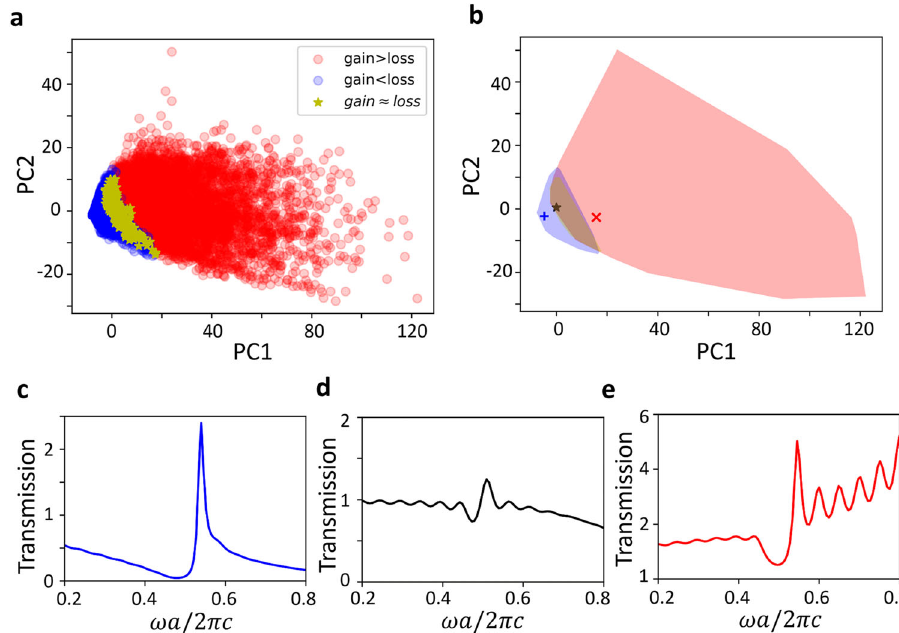
Fig. 3 Principal component analysis for the transmission spectra generated from a fi ve-layer periodic non-Hermitian structure. a Representation of the fi rst two principal components (PC1 and PC2) of the transmission spectra. b The corresponding convex-hulls of the feasible regions for non-Hermitian structures in Fig. 1 in the reduced 2D space. The red, blue, and yellow regions correspond to effective gain, lossy, and balanced media, respectively. The response generated from effective gain and lossy media resides top-right and bottom-left from the center of the latent space, respectively. An overlapping region is found when the gain and loss are balanced with the threshold 10 − 6 . Within this overlapping area, PT -symmetry with perfect transmission exists around the center of the latent space. c – e Representative examples for the transmission spectra versus normalized frequency ω a / 2 π c , with a the dimension of the scatterer and c the speed of light in free space, residing in gain, balanced, and lossy regions of reduced space are presented,